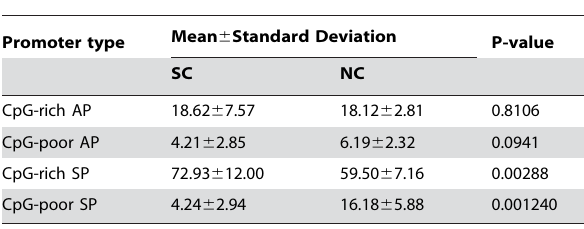
quiescent adult SCs.